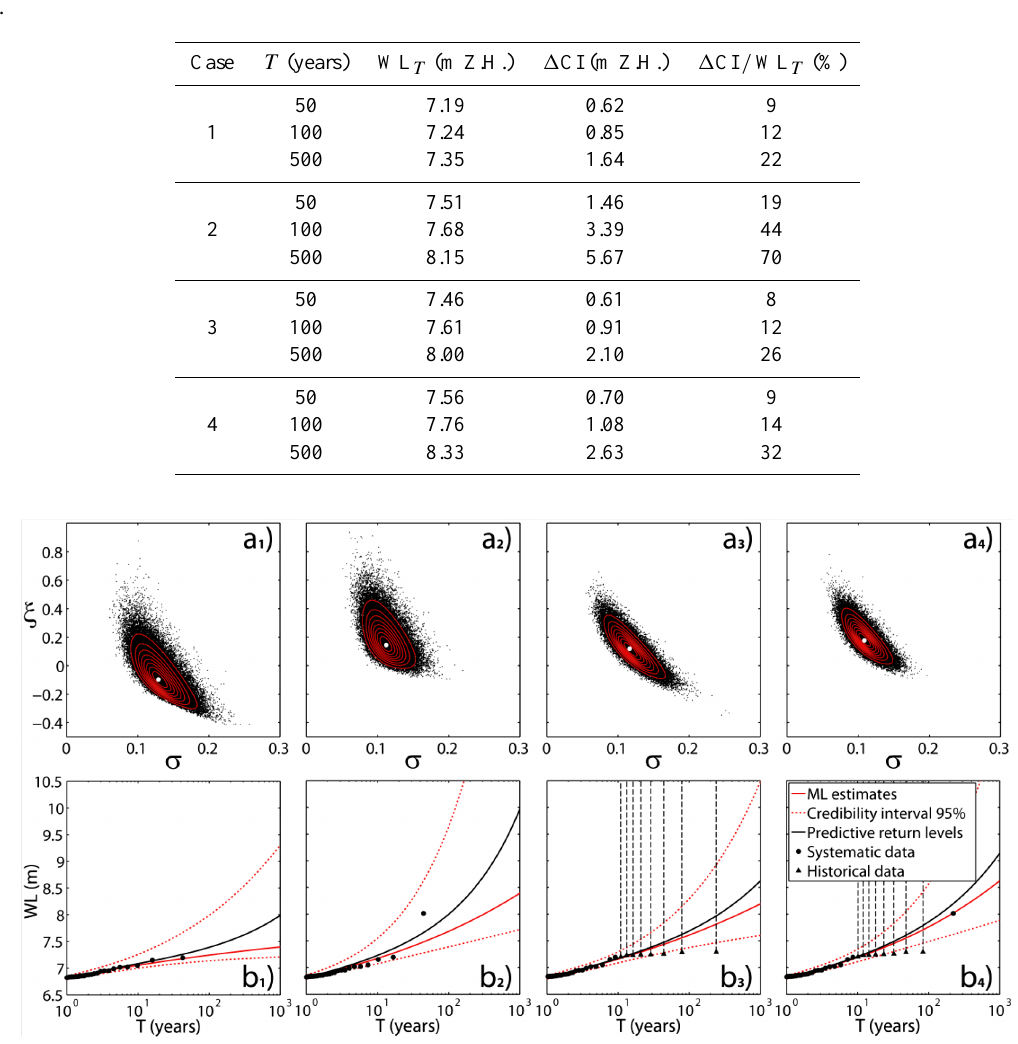
Table 2. Standard estimative return values of WL and widths of the associated 95% central credibility intervals (absolute – (cid:49) CI and relative – (cid:49) CI / WL T ) for several return periods T according to each case: (1) systematic data until the end of 2009, (2) systematic data until the end of 2010, (3) systematic data until the end of 2009 and historical information, (4) systematic data until the end of 2010 and historical information.